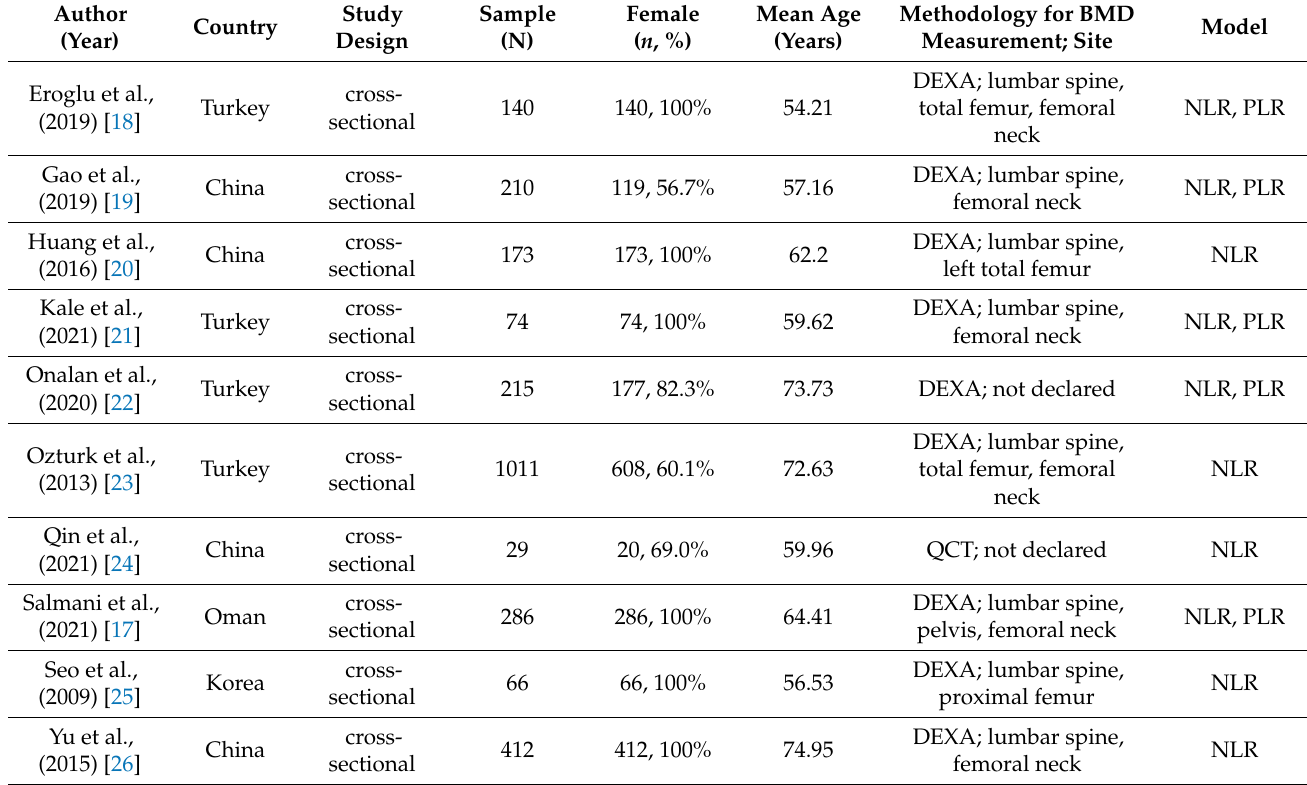
Table 1. Baseline characteristics of the included